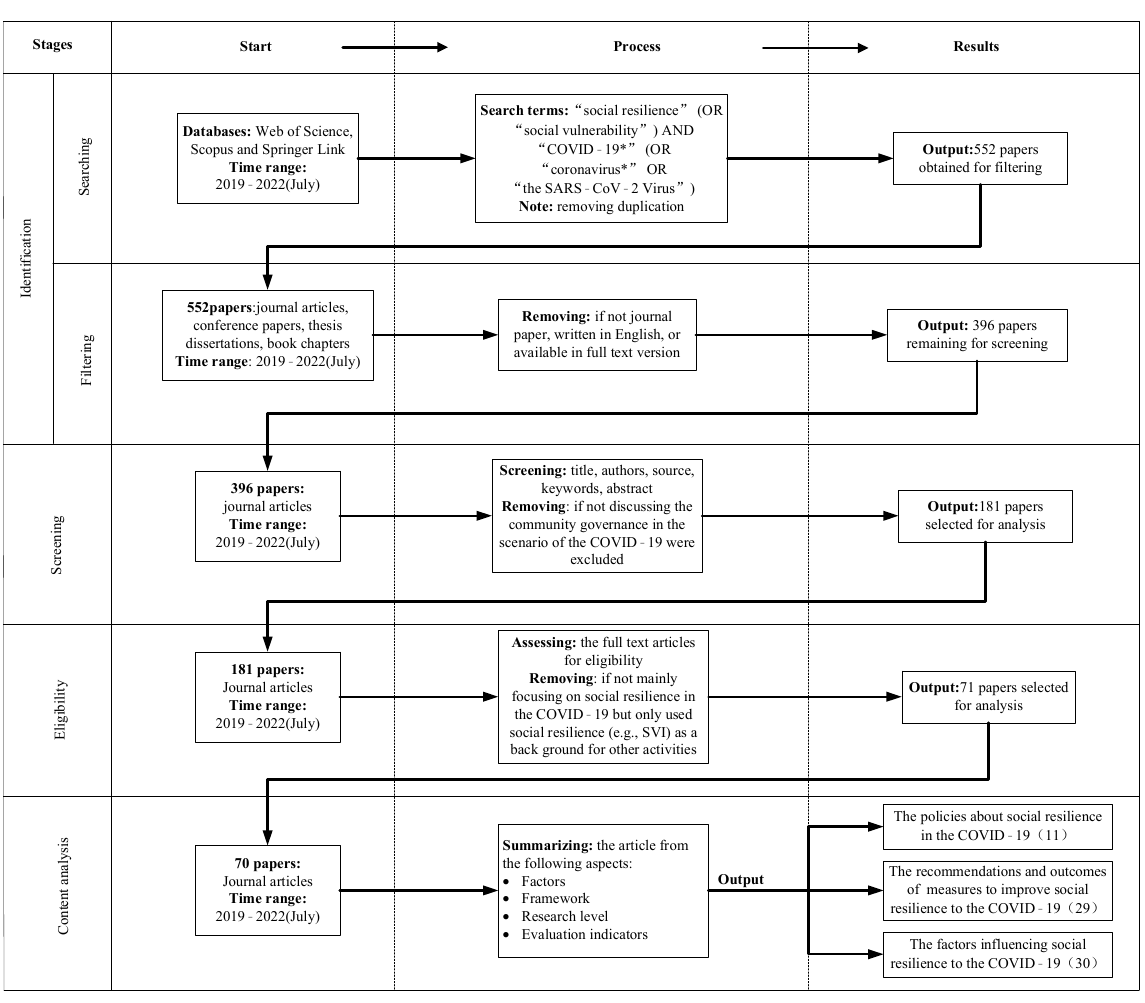
Figure 2. Flow diagram of the literature search and study selection. Table 1. Policies related to social resilience to